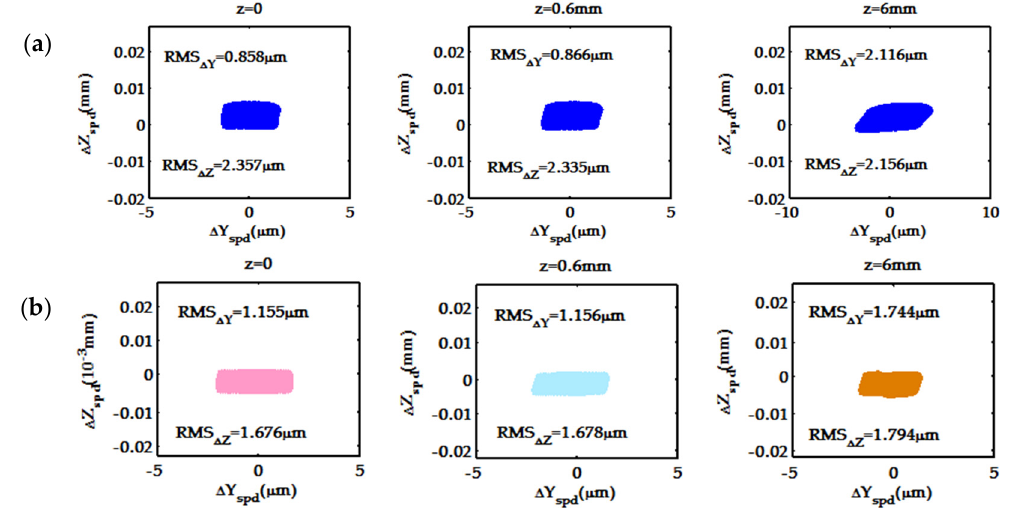
Figure 7. ∆ Y - ∆ Z plots constructed for the model optical system at λ = 700 nm. ( a ) deviations, ∆ Y - Figure 7. Δ Y - Δ Z plots constructed for the model optical system at λ = 700 nm. (a) deviations, Δ Y - ∆ Z, of individual spots in Figure 6a from the corresponding ideal image points (0,0,0), (0,0,0.6) and Δ Z, of individual spots in Figure6a from the corresponding ideal image points (0,0,0), (0,0,0.6) and (0,0,6); ( b ) deviations, ∆ Y - ∆ Z, of individual spots in Figure 6b from the corresponding ideal image (0,0,6);.(b) deviations, Δ Y - Δ Z, of individual spots in Figure6b from the corresponding ideal image points (0,0,0), (0,0,0.6) and points (0,0,0), (0,0,0.6) and (0,0,6)7. Conclusions.